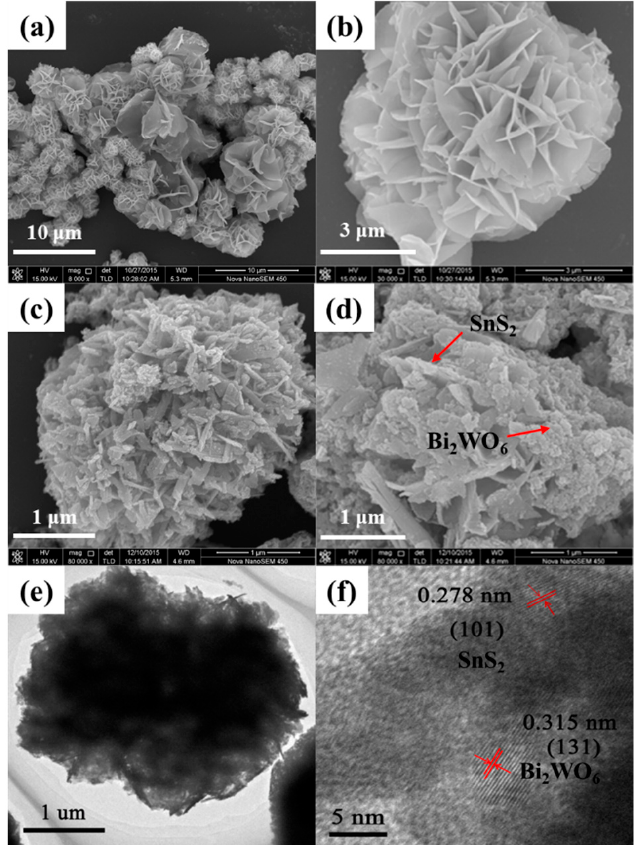
Figure 2. ( a , b ) SEM images of flower-like SnS 2 , ( c , d ) SEM images of SnS 2 /Bi 2 WO 6 -10, ( e , f ) TEM images of SnS 2 /Bi 2 WO 6 -10, red arrows and red lines indicate the lattice spacings.